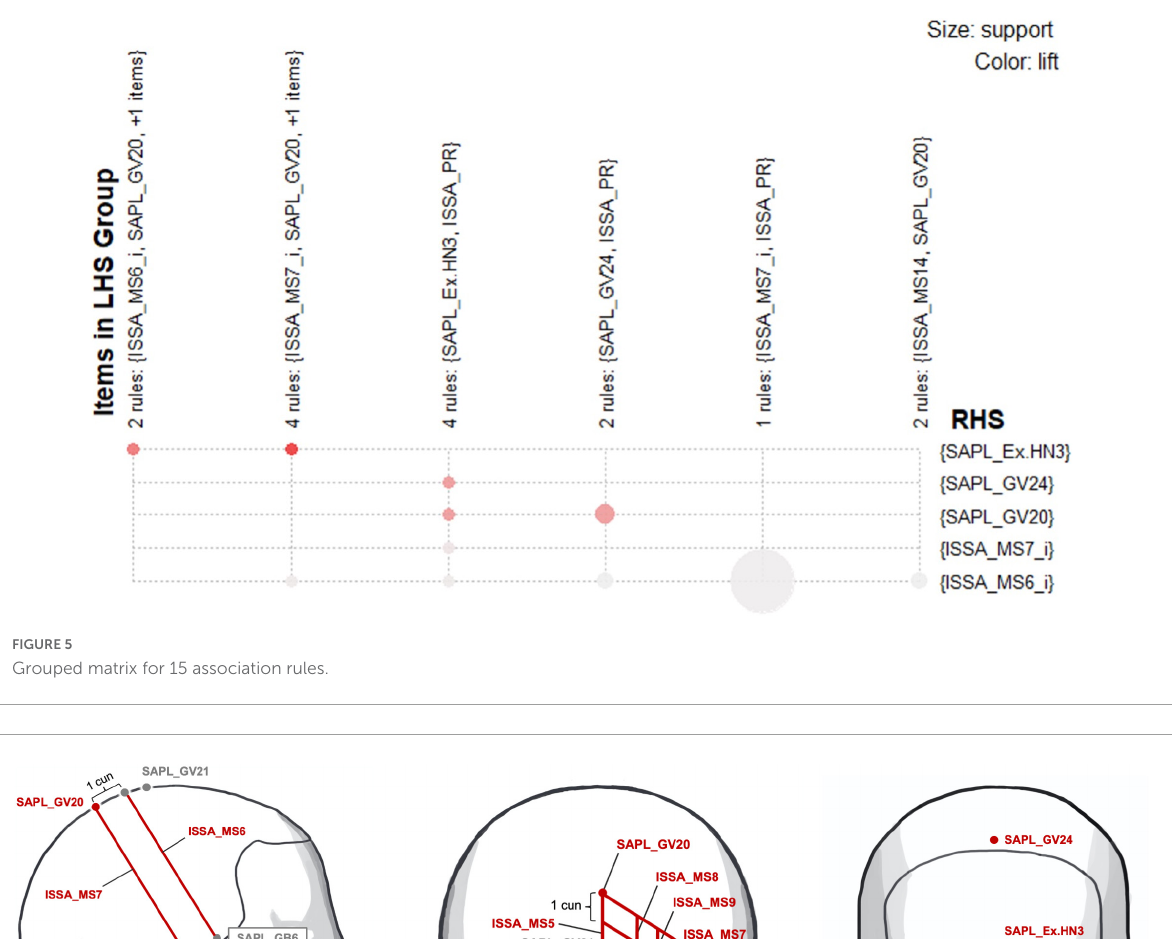
FIGURE6 The core scalp acupuncture (SA) location combinations for the treatment of post-stroke hemiparesis. The core scalp acupuncture location combinations [SAPL_GV20 (Baihui), SAPL_GV24 (Shenting), SAPL_Ex.HN3 (Yintang), ISSA_MS6, ISSA_MS7, ISSA_PR (ISSA Parietal